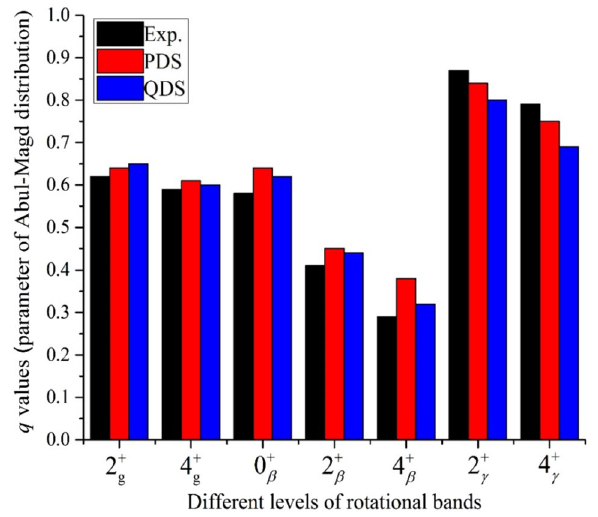
Figure 3. The chaoticity measure of different levels yields by using the experimental data and PDS and QDS